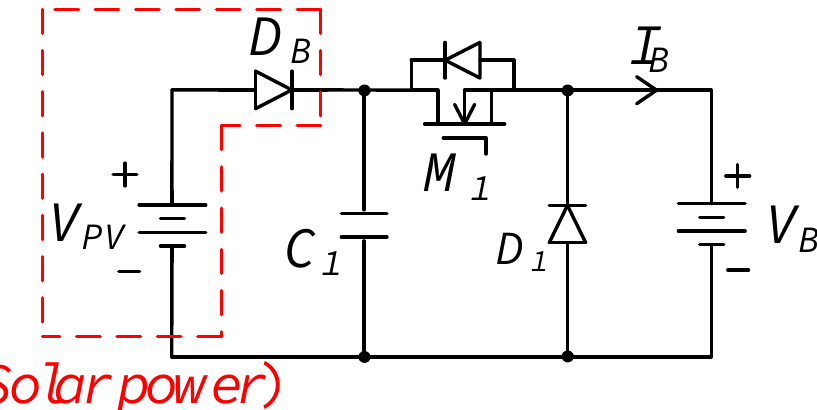
Figure 1. Schematic diagram of flyback converter for battery charging system.